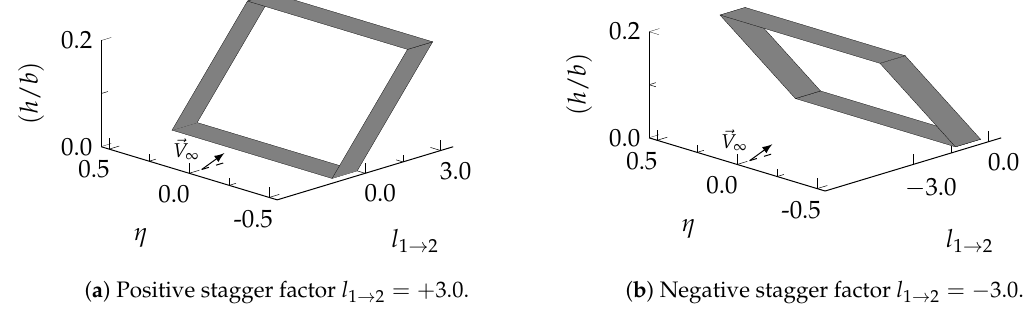
Figure 1. Boxwing planforms for a geometric height-to-span ratio of ( h / b ) =